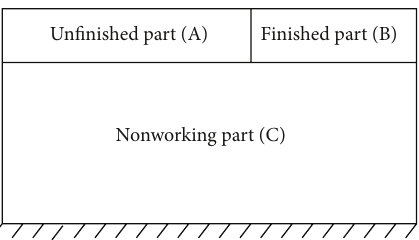
Figure 4: Divided parts of